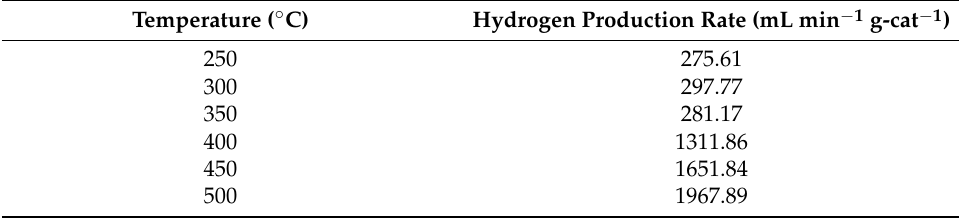
Table 2. Hydrogen production rates of CuYO 2 nanofibers at different